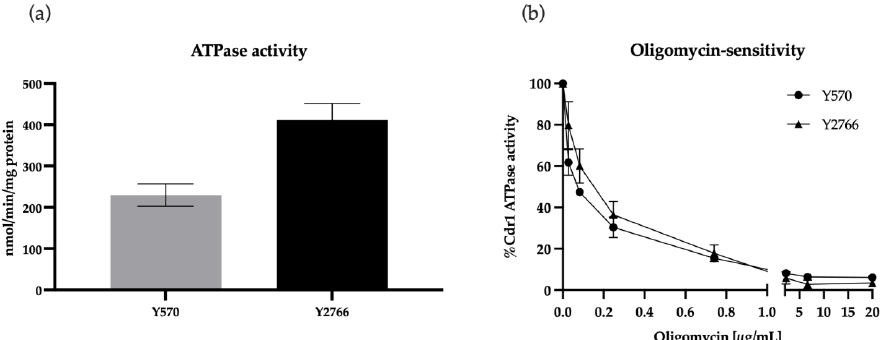
Figure 3. ATPase activity and OM sensitivity of strains overexpressing Cdr1. ( a ) Both strains exhibit ATPase activity. CaCdr1 (Y570) gives half the activity of CauCdr1 (Y2766). ( b ) Dose-dependent inhibition of Cdr1 ATPase activity with OM confirms the expected ATP-dependence pump function and specificity of CaCdr1 and CauCdr1. Bars represent standard deviation of 3 biological replicates ( n = 3).